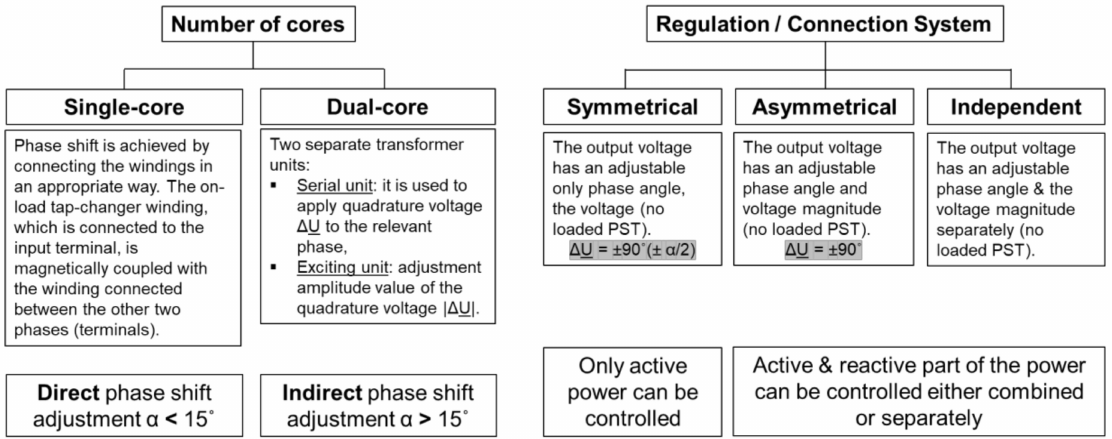
Figure 2. Division of PSTs by design and